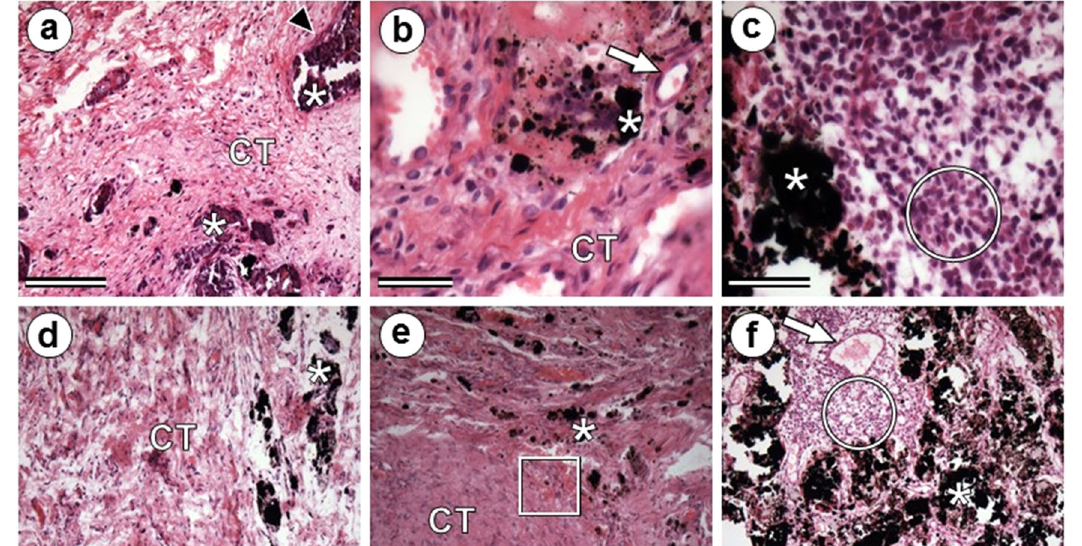
hyperemia; arrowhead: fi brous capsule formation; circle: in fl ammatory in fi ltrate; square: bleeding; CT: conjunctive tissue. ( a ), ( c ), ( d ), and ( f ):